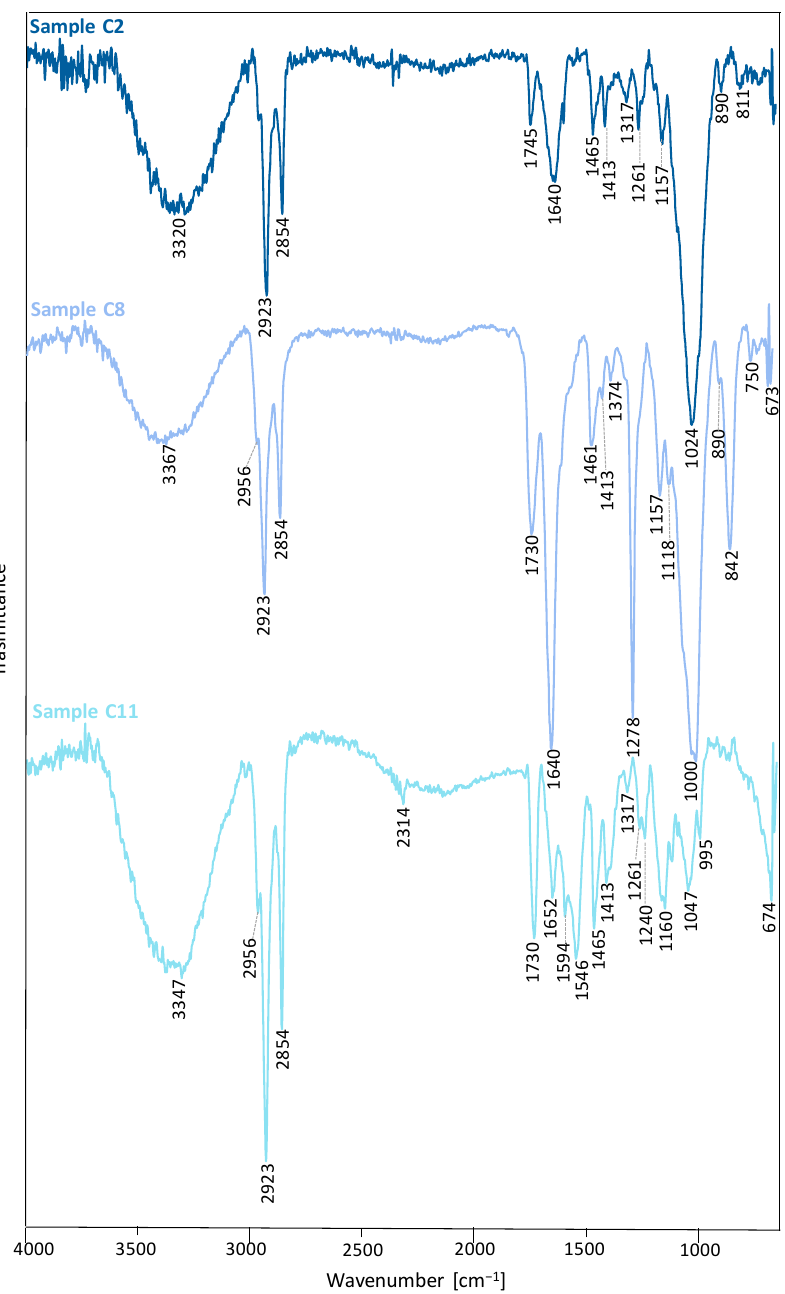
Figure 2. Attenuated Total Reflection- Fourier Transform Infrared (ATR-FTIR) spectra acquired for samples C2, C8, and C11 (from top to bottom).